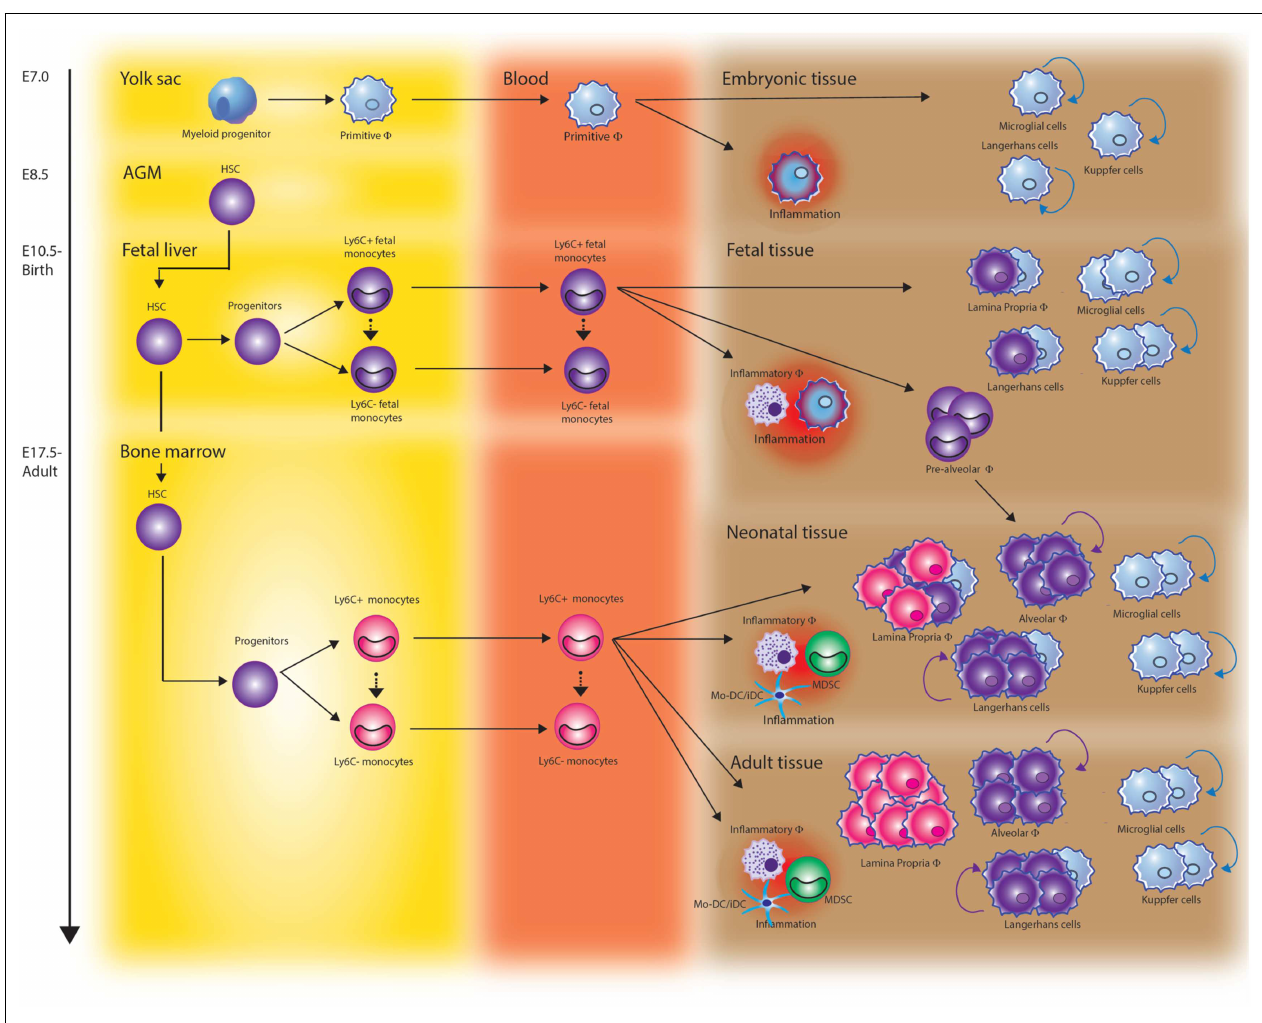
birth, these cells rapidly differentiate into long-lived alveolar macrophages (AMF) via a “pre-AMF,” intermediate differentiation stage. Fetal monocyte-derived Langerhans cells show vigorous proliferation after birth while lamina propria macrophages are continuously renewed via differentiation of bone marrow-derived monocytes. In addition to these resident macrophage populations, Ly6C high monocytes can be recruited to sites of infection or injury and differentiate into inflammatory macrophages, monocyte-derived dendritic cells (Mo-DCs), or myeloid-derived suppressor cells (MDSCs).